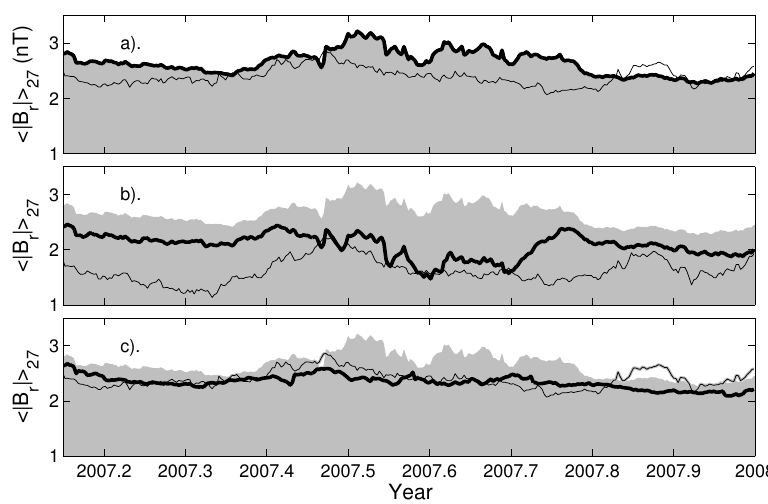
Figure 19: Application of the “kinematic correction” to the third Ulysses perihelion pass shown in Figure 17. All three panels show 27-day running means of various estimates of the absolute radial field (normalized to 𝑟 = 𝑟 1 = 1 AU) from measurements by Ulysses (thick black lines) and ACE (thin black lines). Ulysses data from the top panel are shown by the area shaded grey in all three panels to facilitate comparisons. a) the asymptotic limit of the timescale 𝑇 → 0, ⟨| 𝐵 𝑟 ( 𝑟 1 ) | 𝑇 → 0 ⟩ 27d (for ACE data, thin black line) and ( 𝑟 𝑈 /𝑟 1 ) 2 ⟨| 𝐵 𝑟 ( 𝑟 𝑈 ) | 𝑇 → 0 ⟩ 27d (for Ulysses, thick black line); (b) the same for T = 1 day, ⟨| 𝐵 𝑟 ( 𝑟 1 ) | 1d ⟩ 27d (thin black line) and ( 𝑟 𝑈 /𝑟 1 ) 2 ⟨| 𝐵 𝑟 ( 𝑟 𝑈 ) | 1d ⟩ 27d (thick black line); and (c) data for T = 1 h with the kinematic correction applied to the Ulysses data to allow for heliospheric effects between 𝑟 𝑈 ) (thick black line). Image and 𝑟 1 , ⟨| 𝐵 𝑟 ( 𝑟 1 ) | 1h ⟩ 27d (thin line) and ( 𝑟 𝑈 /𝑟 1 ) 2 ⟨| 𝐵 𝑟 ( 𝑟 𝑈 ) | 1h ⟩ 27d − Δ 𝐹/ (2 𝜋𝑟 2 𝑈 reproduced by permission from Lockwood et al. (2009b), copyright by